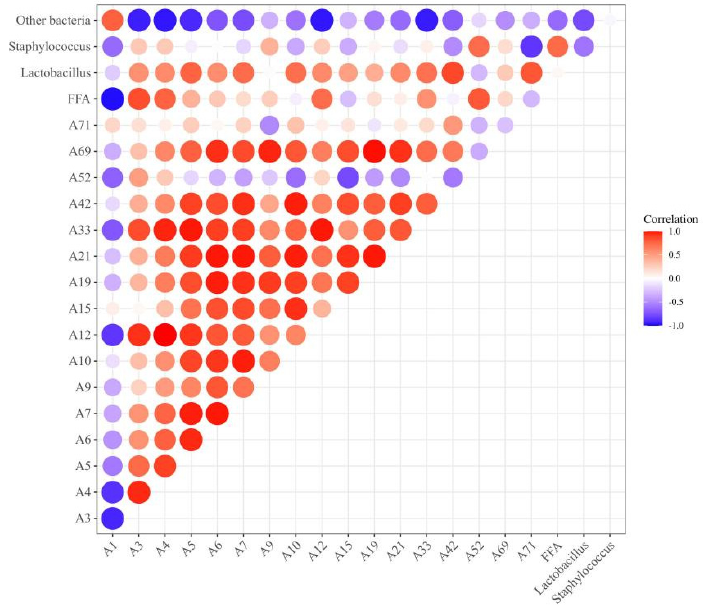
Figure 7. Heat map of correlation among bacterial relative abundance, FFA content, and differential flavor compounds. Positive correlation (0 < r < 1) and negative correlation ( − 1 < r < 0) were shown by red and blue color, respectively. A1: hexanal; A3: heptaldehyde; A4: (Z)-hept-2-enal; A5: (E)-2-octenal;